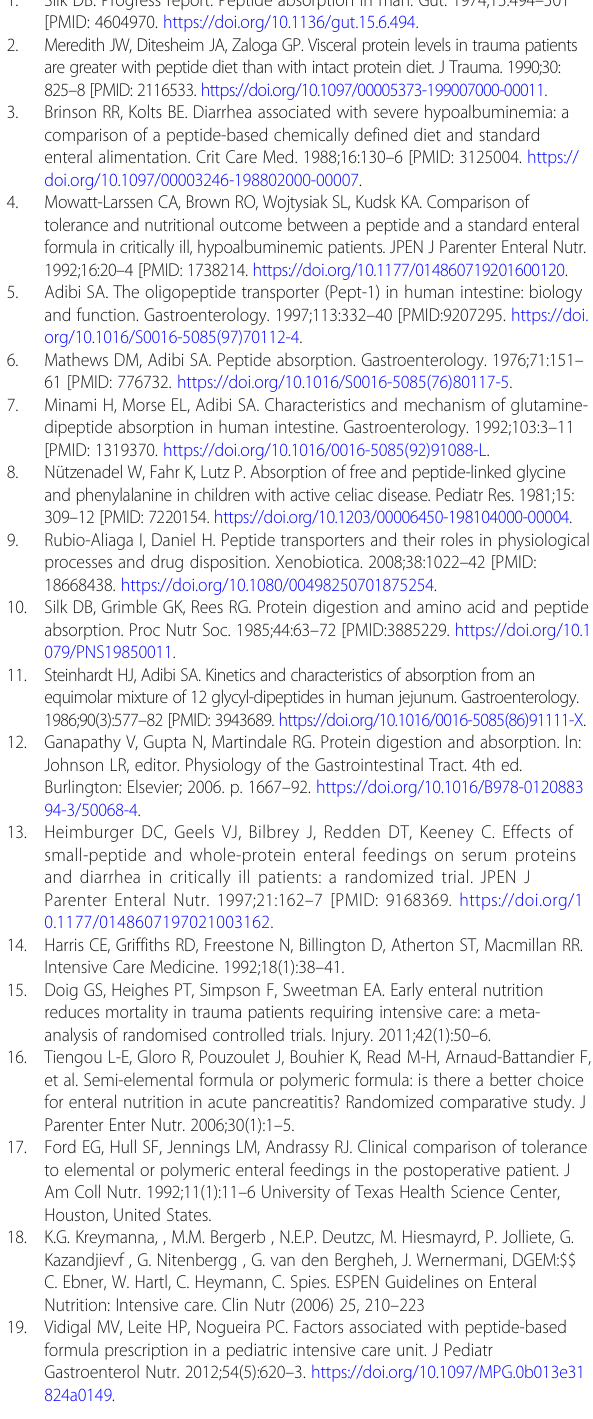
Table 3 Average hospital stay in both groups Group Student t test Peptide based